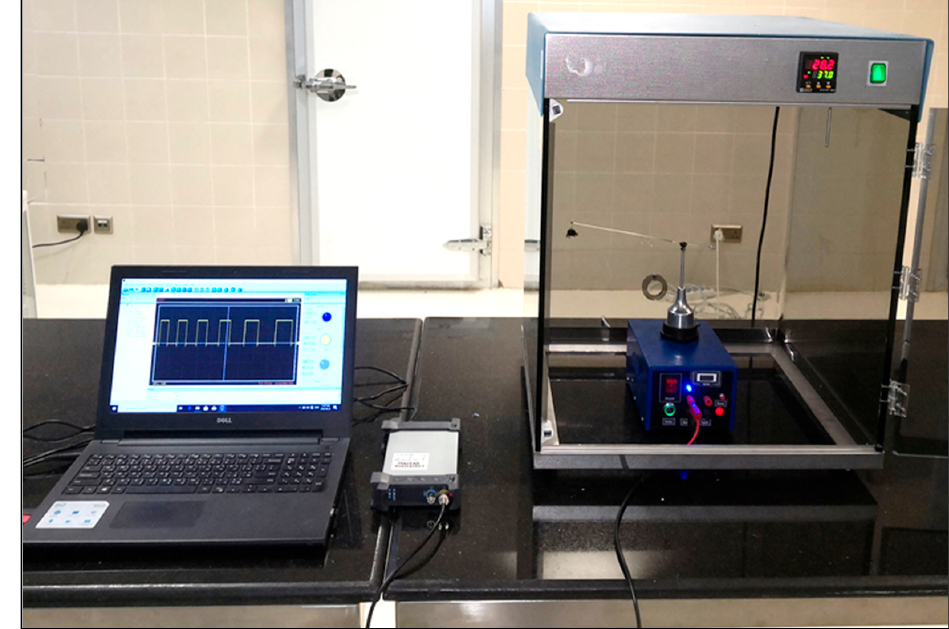
Figure 2. Image of the computerized flight-testing system.